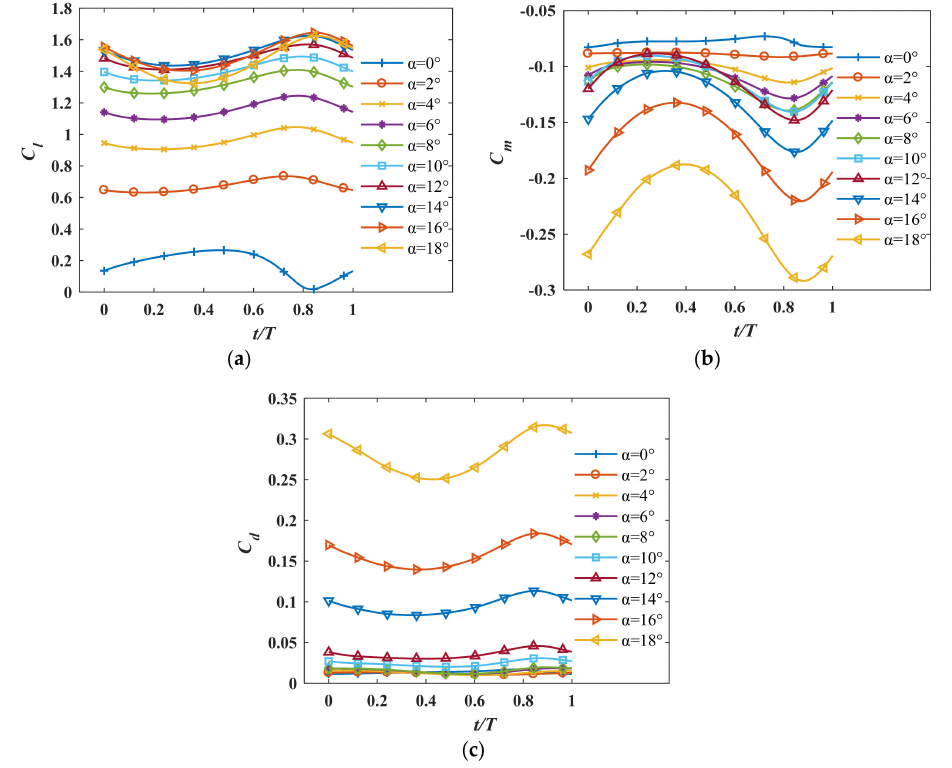
Figure 6. The change in aerodynamics in a period: ( a ) lift coe ffi cient, ( b ) moment coe ffi cient, ( c ) drag coe ffi